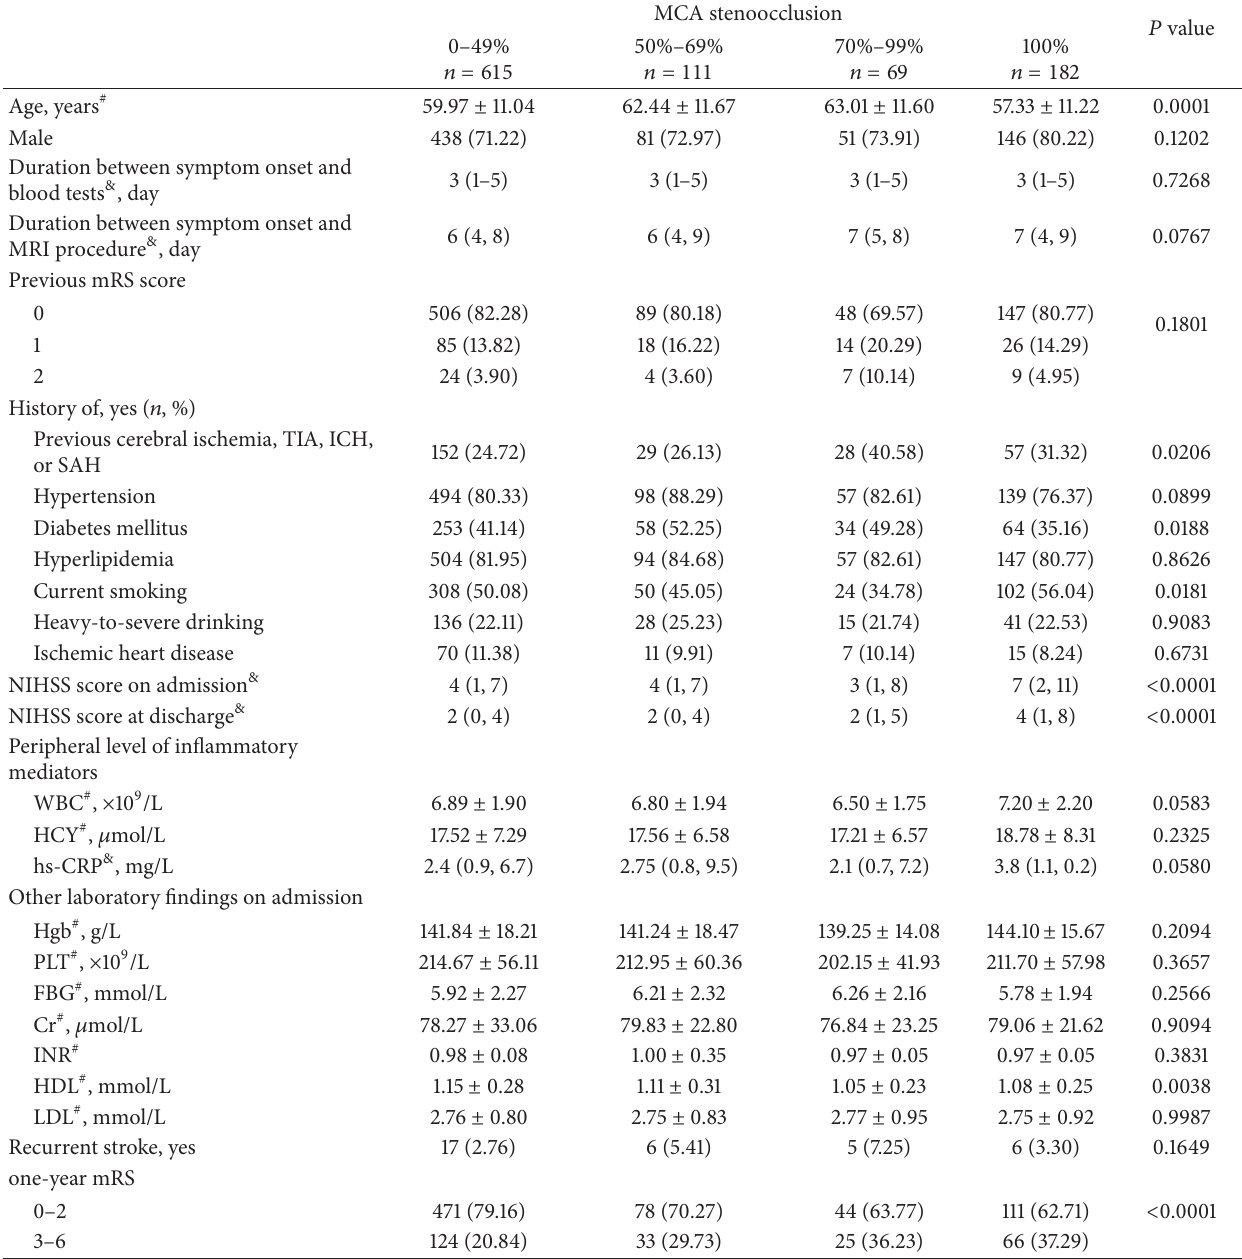
Table 2: Patients’ characteristics by categorized MCA